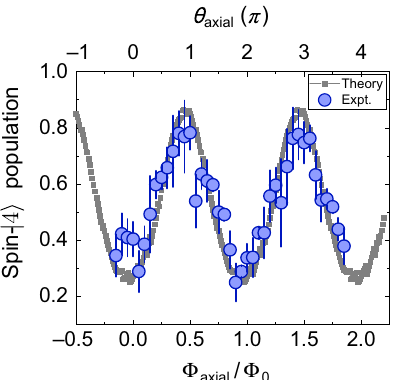
FIG. 10. Calibration of the axial phase and axial magnetic flux. Spin- | 4 (cid:2) population versus θ axial ( (cid:9) axial ) at the end of a 90- μ s pulse, composed of microwaves and rf waves and applied to a BEC initially prepared at | 4 (cid:2) . In this case, (cid:2) 1 ( 2 ) = 2.2 ( 3.2 ) E r and (cid:2) rf1(rf2) = 1.1 ( − 1.6 ) E r . Blue circles are experimental data and black dots are numerical results obtained by solving the time- dependent Schrödinger equation. Error bars are standard errors of typically five repetitive